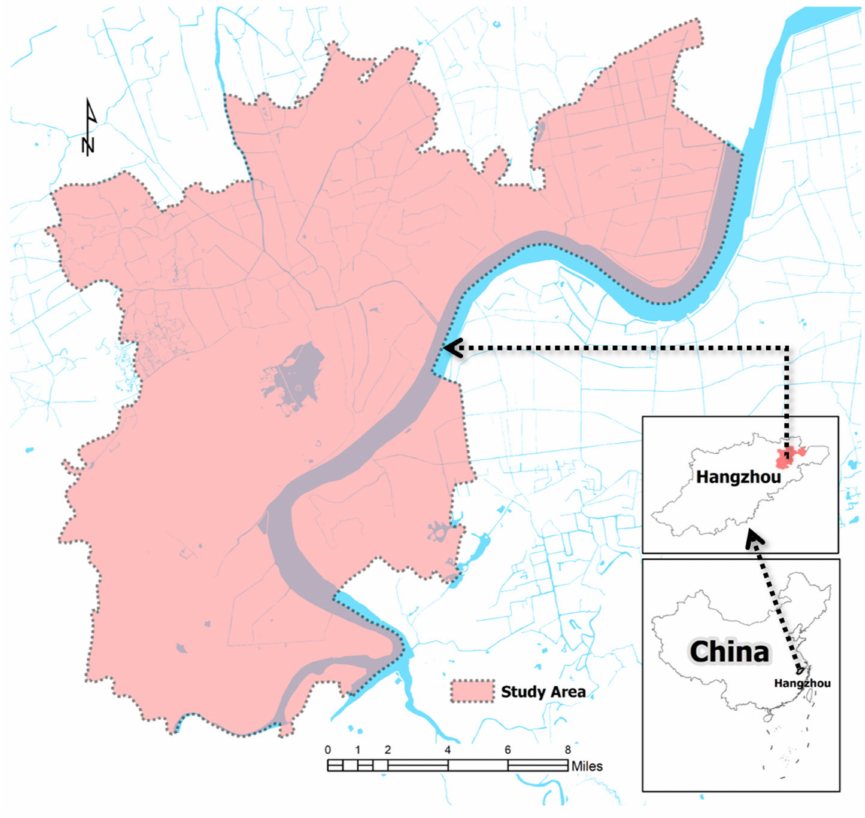
Figure 1. Location of Hangzhou city, China. Table 2. Statistics on the number of sample points for commercial land transactions in